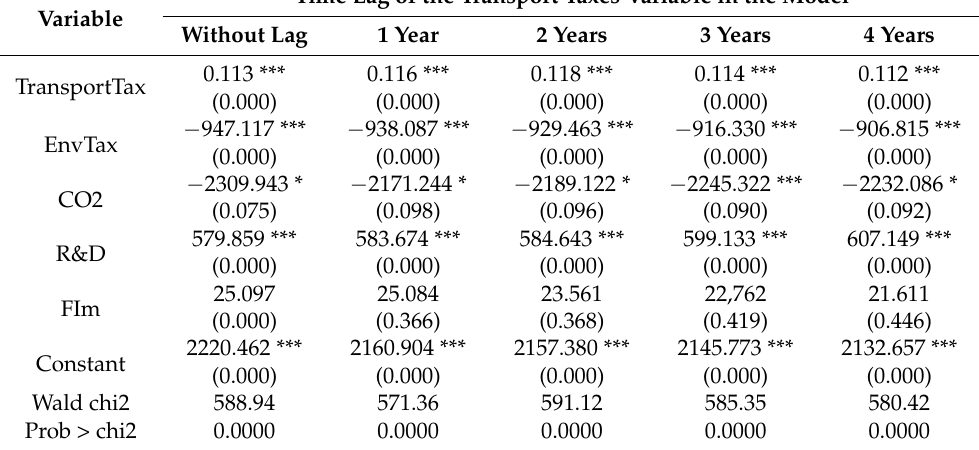
Table 2. Results of the assessment of transport taxes impact on the biofuel production in the European countries for 2010–2020. Time Lag of the Transport Taxes Variable in the Variable